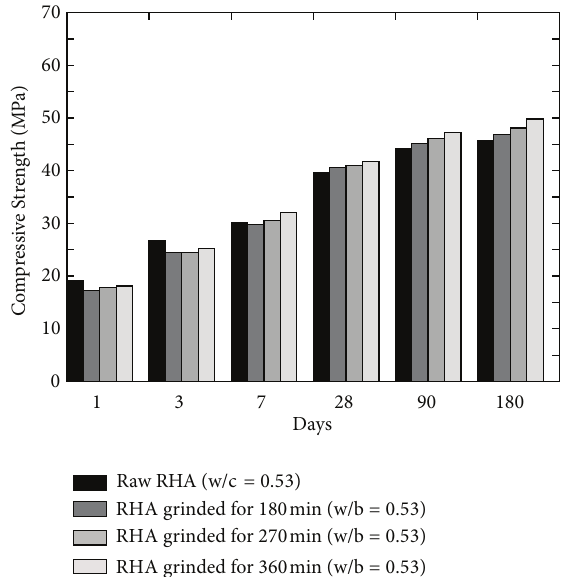
Figure 13: Effect of grinding timings on the compressive strength of RHA concrete